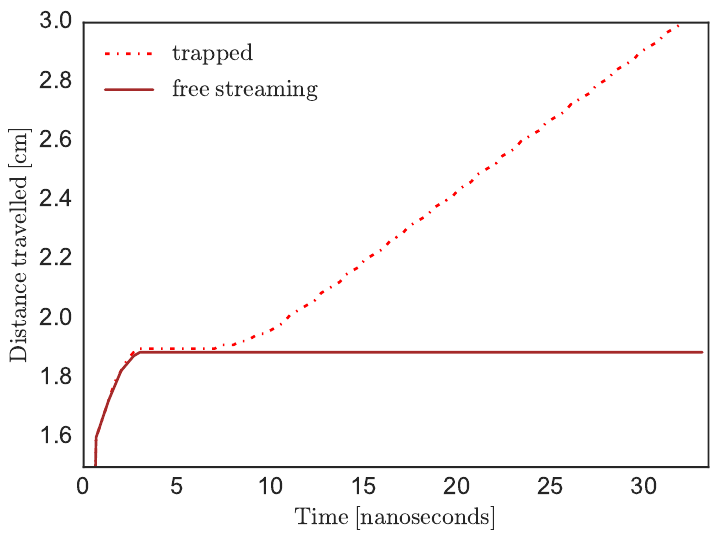
Figure 2. Distance travelled by the combustion front as a function of time from a numerical simulation. The line labeled as “free streaming” represents the burning front with neutrinos free streaming, while the line labeled as “trapped” plots the burning front with trapped neutrinos. Notice how the front halts for the remainder of the simulation for the free streaming case. The thermodynamic parameters for the simulation were an initial temperature of T = 20 MeV, an initial lepton fraction of Y L = 0.2, and an initial baryonic density of n B = 0.35 fm − 3